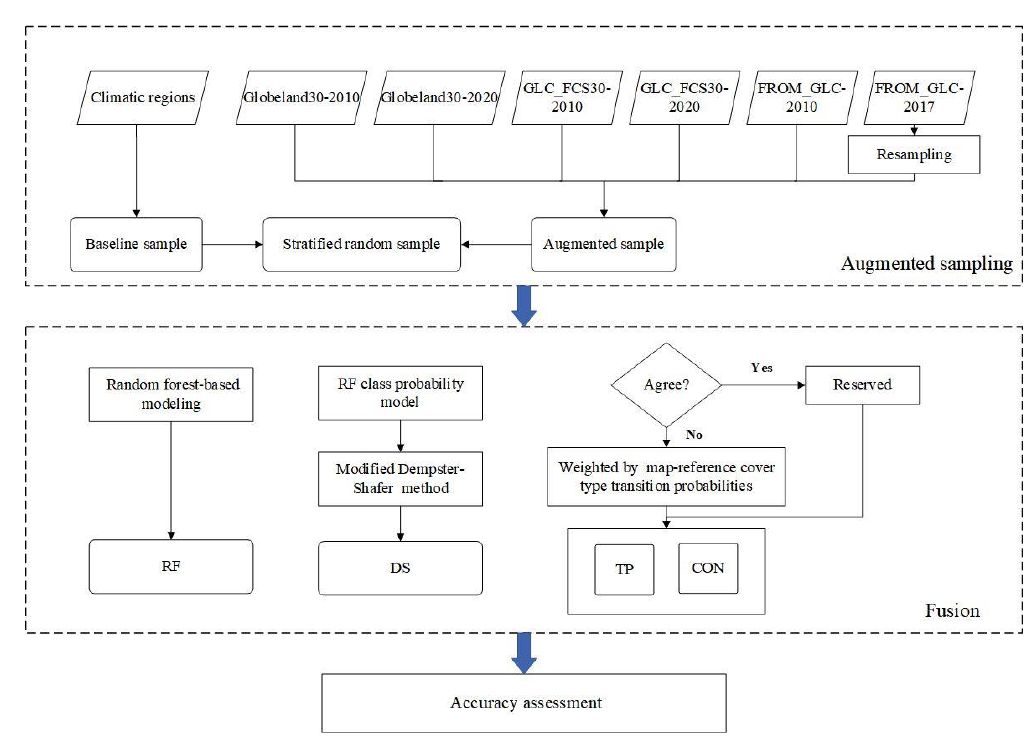
Figure 2. The flowchart of fusion process of the multiple land cover products.